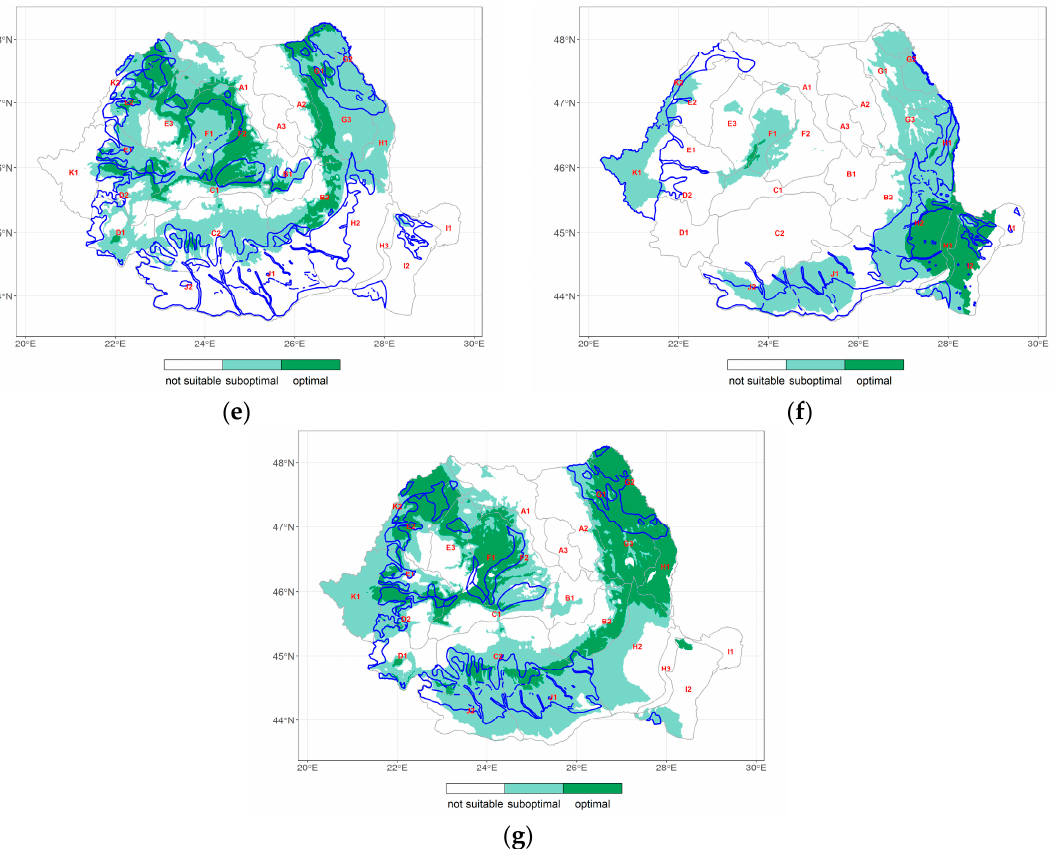
Figure 16. Climate envelope of: ( a ) Norway spruce; ( b ) silver fir; ( c ) European beech; ( d ) sessile oak; ( e ) pedunculate oak; ( f ) Quercus pedunculiflora and pubescent oak; ( g ) Hungarian oak and Turkey oak. The blue polygons show the current spatial distribution.